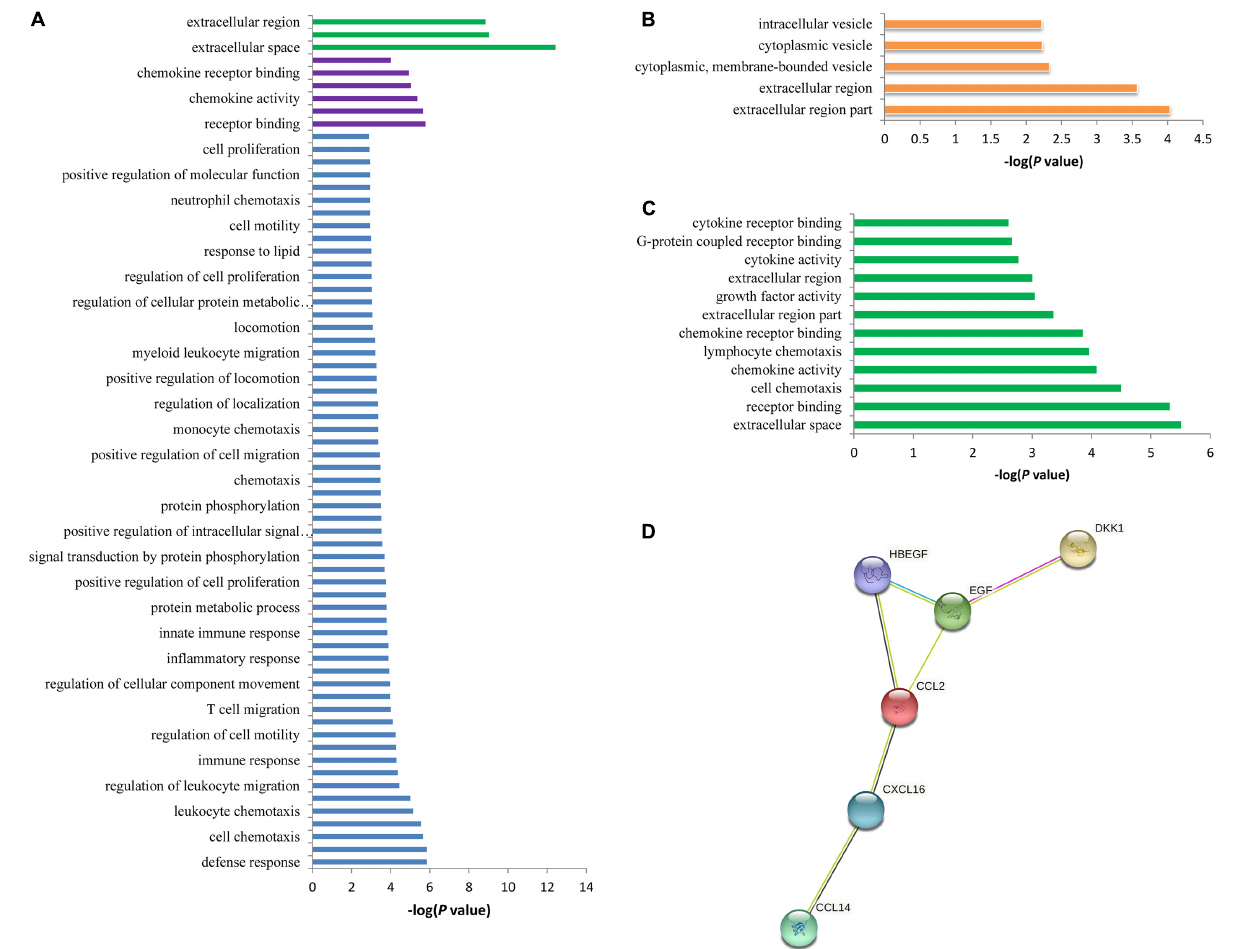
FIGURE 3 | Functional annotation enrichment analysis of the spontaneous coronary artery dissection (SCAD)-related proteins. (A) There were 68 statistically significant Gene Ontology (GO) terms that were enriched in the SCAD-related proteins. (B) The seven proteins (ADAMTS4, DDC, B2M, CCL20, CRISP3, ECM1, and TSHB) that may be affected by rs12758270 were enriched in five GO terms. (C) The six proteins (CCL2, CXCL16, DKK1, HBEGF, EGF, and CCL14) that may be affected by rs3818978 were enriched in 12 GO terms. (D) Protein–protein interactions between the six proteins that may be affected by